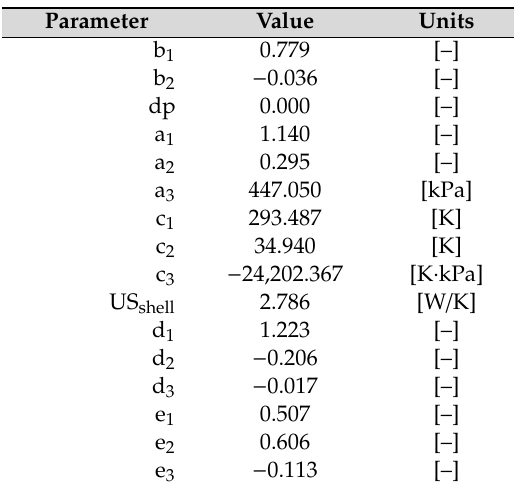
Table A1. Off-design calculation model parameters for a dataset of variable speed reciprocating